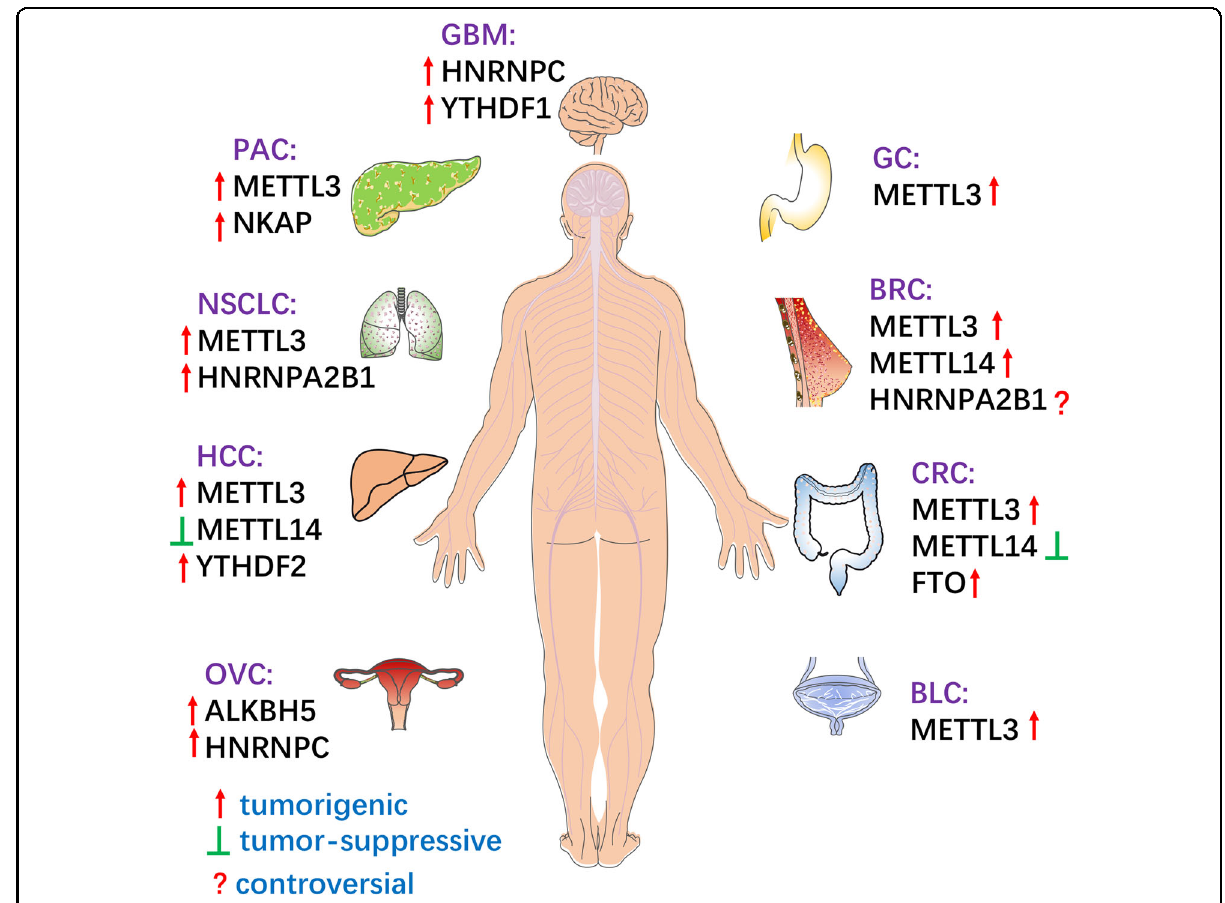
Fig. 4 m6A modi fi cations in different human cancers. m6A modi fi cations participate in tumorigenesis and metastasis in different cancers. BLC, bladder cancer; CRC, colorectal cancer; BRC, breast cancer; GBM, glioblastoma; GC, gastric cancer; PAC, pancreatic cancer; NSCLC, non-small cell lung cancer; HCC, hepatocellular carcinoma; OVC, ovarian